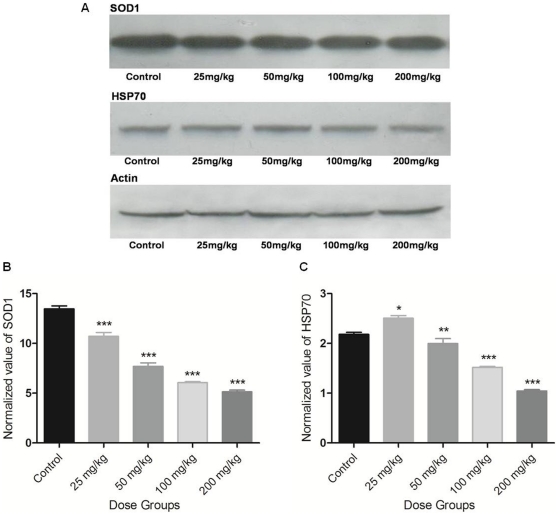
Western blot analysis of SOD1 and Hsp70.(A) Western blots of SOD1, Hsp70 and Actin genes. Relative band intensity value of (B) SOD1, and (C) Hsp70 after normalization with Actin. The asterisks indicate significance of differences (*-p<0.05; **-p<0.01; ***-p<0.001) in comparison to control.